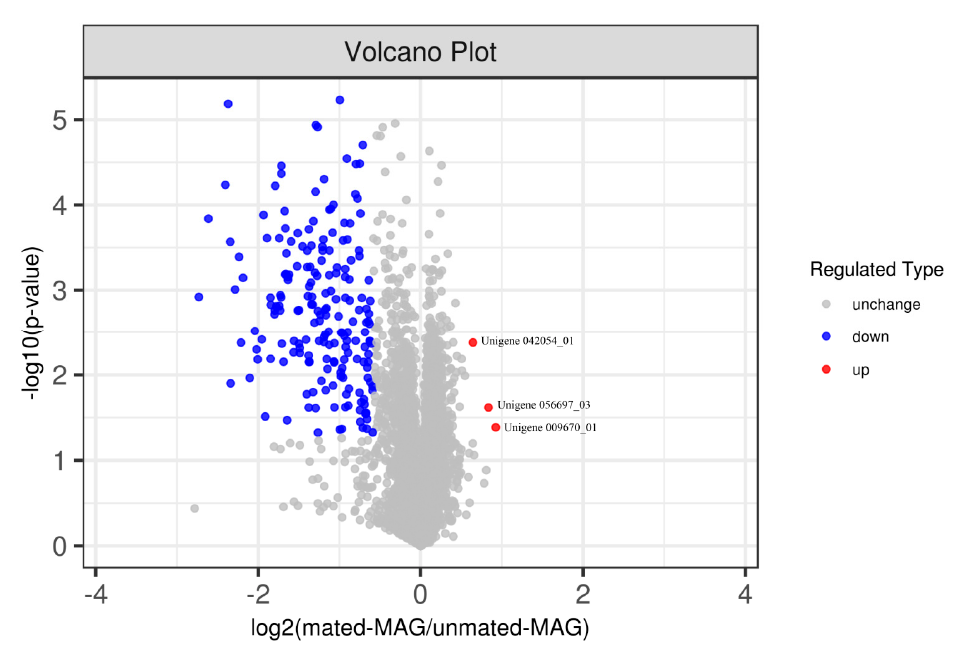
Figure 2. Volcano plot of the differentially abundant proteins (DAPs). The x-axis represents a log2 fold change (mated-male accessory gland (MAG)/unmated-MAG) and the y-axis represents a negative logarithm (log10 scale) of the p -value. Each dot represents a protein. Red dots indicate up-regulated proteins. Blue dots indicate down-regulated proteins. Grey dots represent proteins with non-significant differences (from Student’s t -test). The farther away from zero that the point is, the more significant the